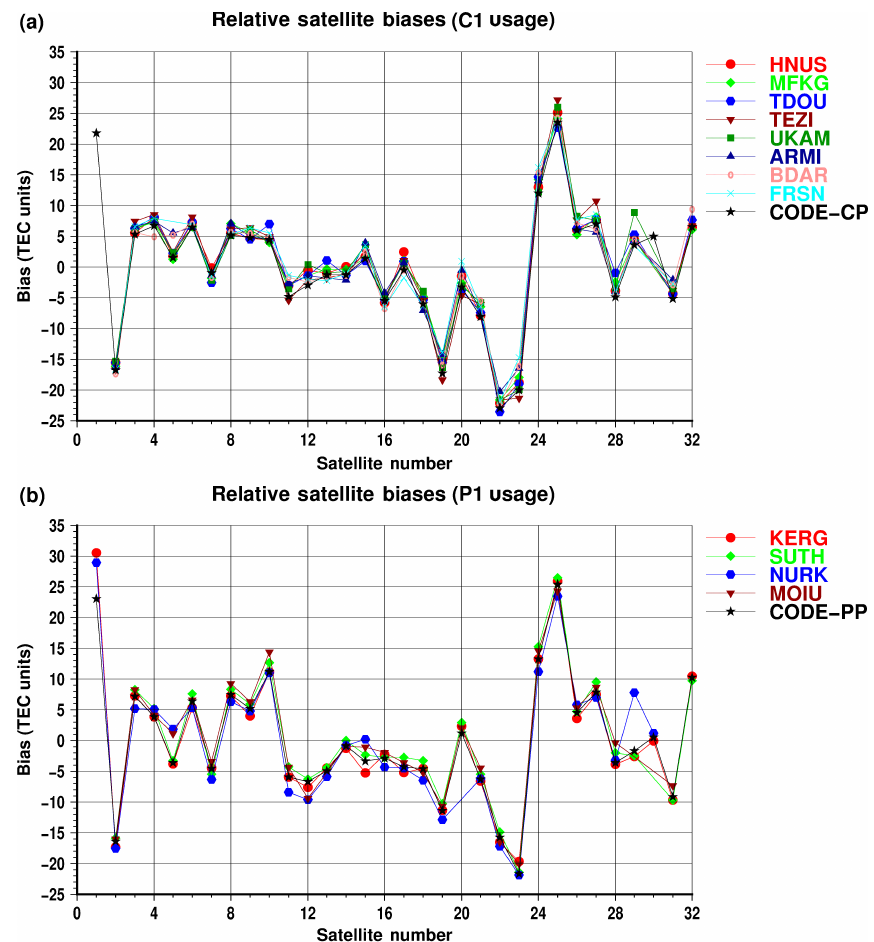
Figure 8. The derived relative satellite biases, resulting from the removal of the receiver bias, separately for the receivers for which the coarse acquisition (C1) signal is used (a) instead of the precise code (P1) signal (b)